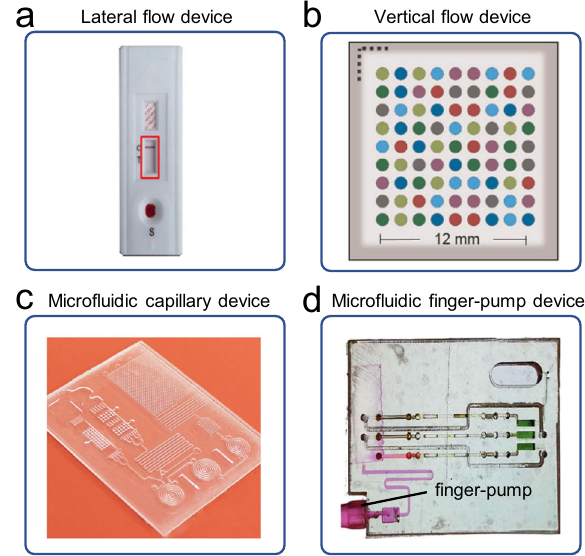
Fig.1|Architectureofmachinelearning-enabledmHealthplatformsforPOCT. The micro fl uidic chip is responsible for biosample processing and testing. The Fig. 2 | Micro fl uidic chips for testing. a A lateral fl ow device ( fi gure adapted with permission from Turbé et al. 7 ). b A vertical fl ow device ( fi gure adapted with per- mission from Ballard et al. 19 ). c A micro fl uidiccapillary device( fi gureadaptedwith permission from Ghosh et al. 47 ). d A micro fl uidic fi nger-pump device ( fi gure adapted with permission from Comina et al. 48